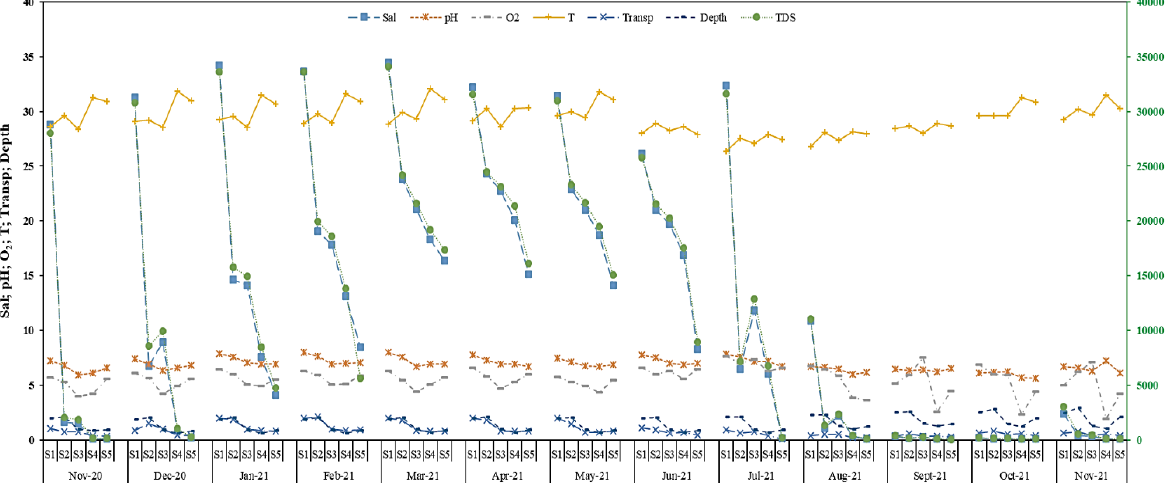
Figure 5. Seasonal evolution of environmental variables in the five stations (S1–S5 from left to right) of Lake Nokoué- inlet complex. Sal = Salinity (ppt); pH = Potential Hydrogen; O 2 = Dissolved Oxy- gen (mg/L); T = Temperature (°C); Transp = Transparency (m); TDS = Total Dissolved Solids (mg/L); Depth = Water depth (m).